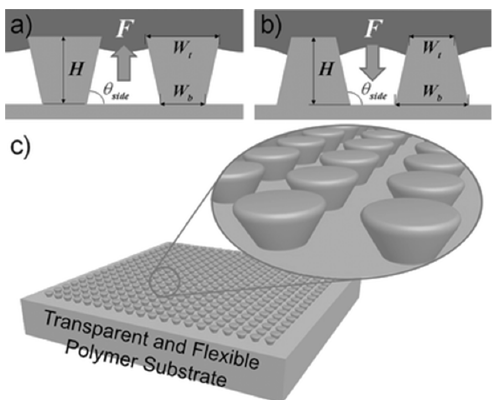
Figure 13. Water meniscus and the net force on: ( a ) overhang structures ( W t > W b ); ( b ) structures like truncated pyramids with inclined sidewalls ( W t < W b ); ( c ) Schematic illustration of the PDMS trapezoids surface [39].